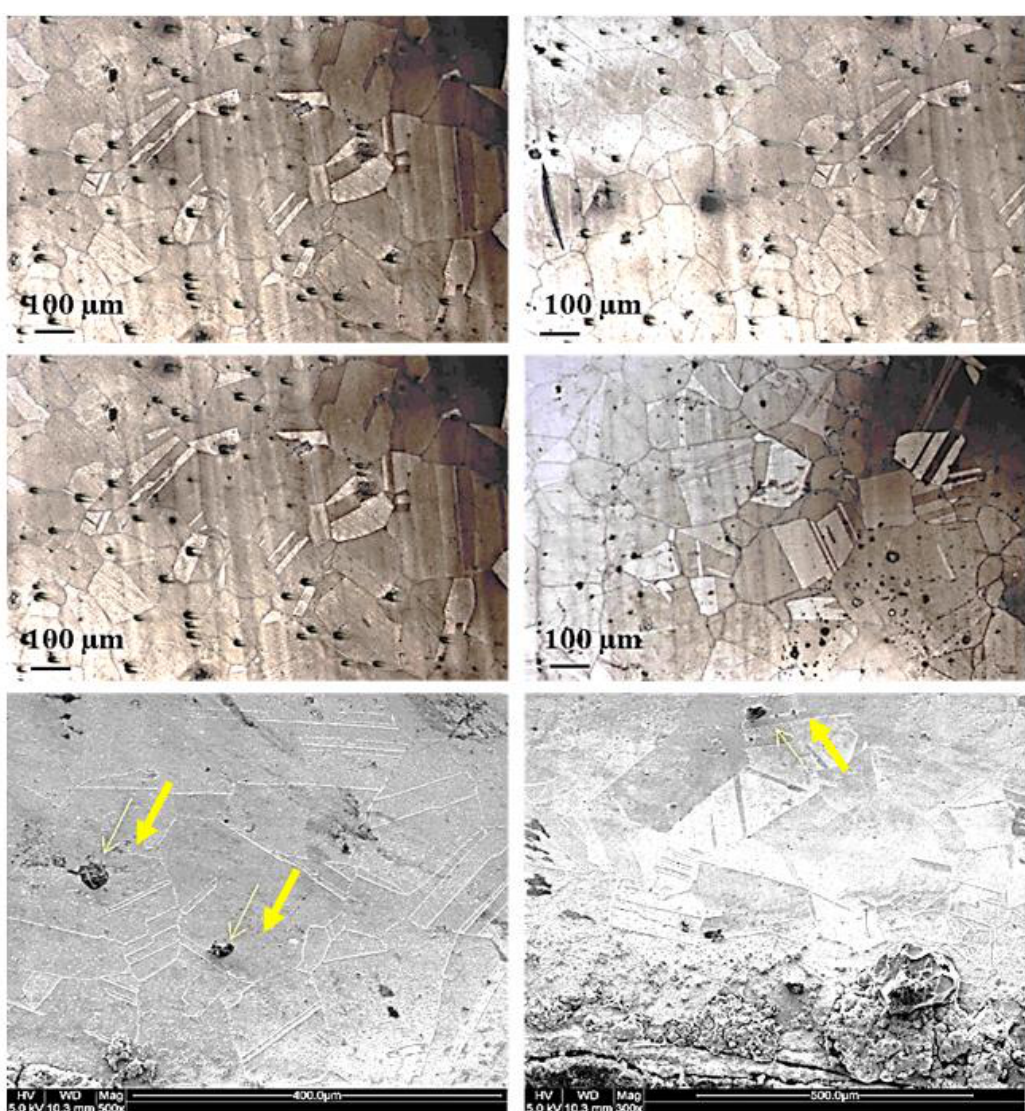
Figure 6. The microstructure of Incoloy 800H, the yellow arrows show the twinning system as well as the presence of precipitates .